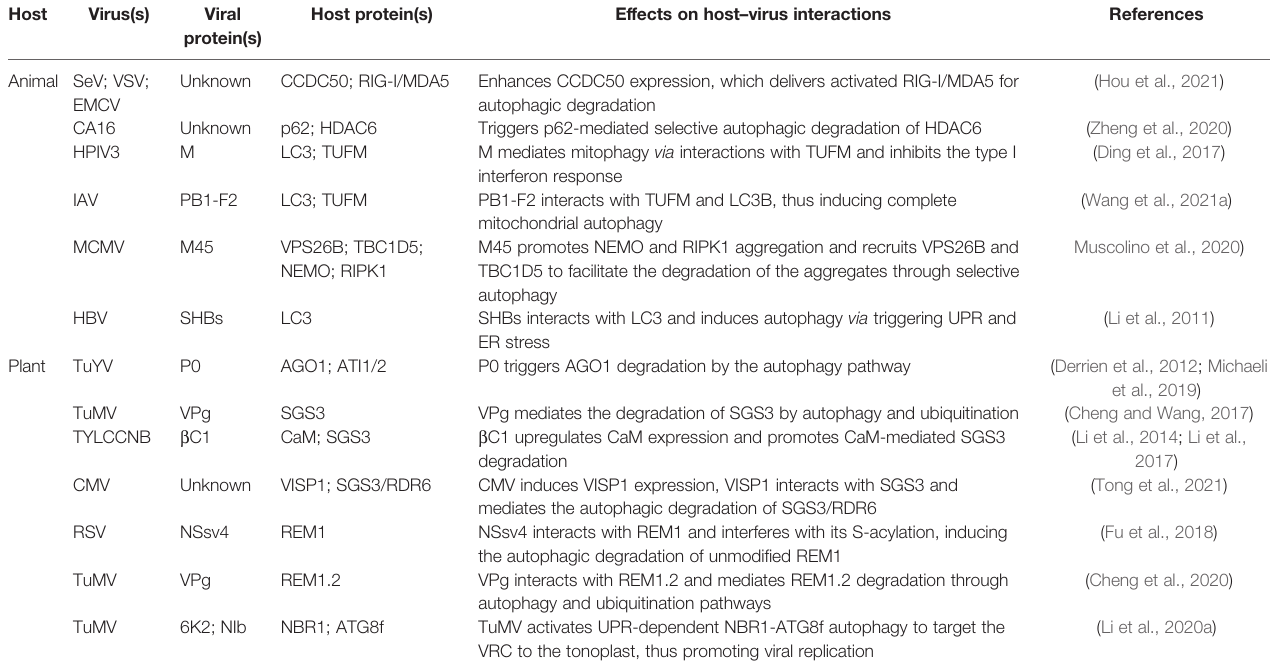
TABLE 3 | Autophagy is manipulated by